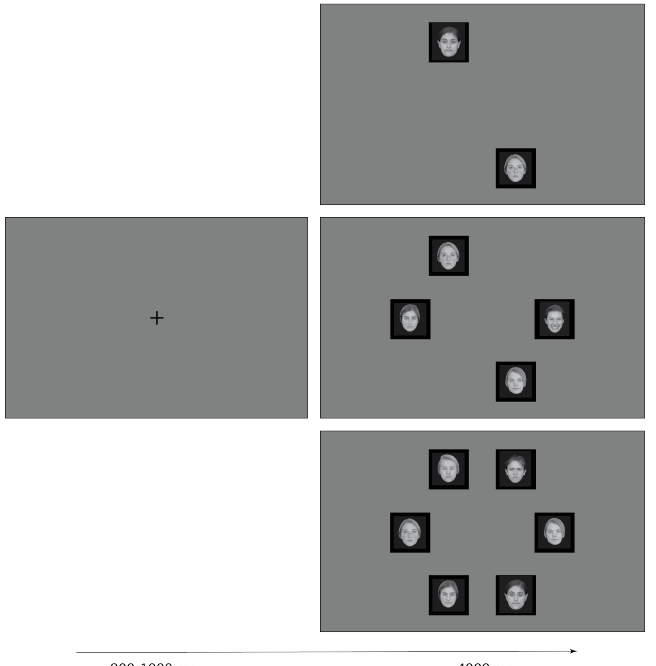
Figure 1. Example sequence of events in a single trial. The fixation cross was on the screen for a jittered interval between 800 and 1000 ms. The array of face stimuli stayed on screen until the participant responded, or for a maximum of 4 s. The subsequent trial began immediately after the participant’s response. Stimulus arrays were sets of 2, 4, or 6 face images. Example stimulus arrays for target absent trial ( top ), target present trial in the happy condition ( middle ), and target present trial in the angry condition ( bottom ) are depicted in the right panel of the figure. The happy and angry conditions were